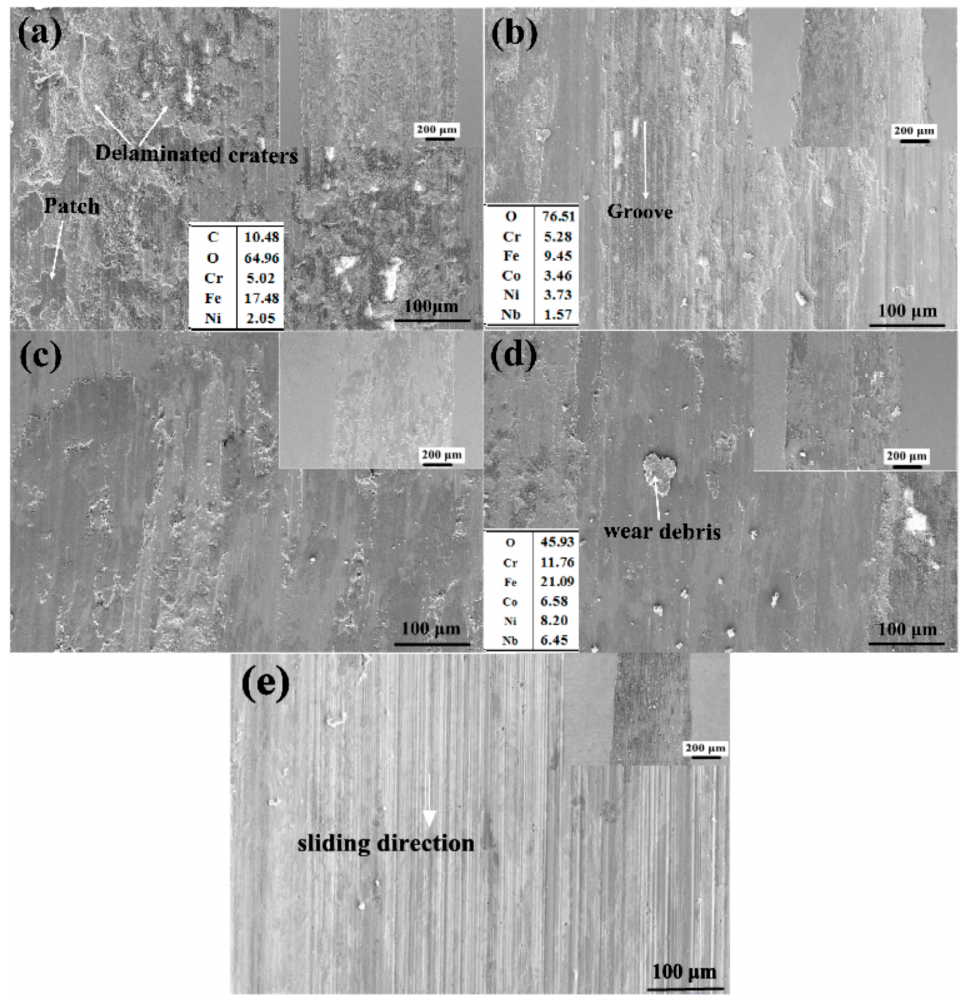
Figure 6. The SEM micrographs of worn surface of samples: ( a ) Substrate, ( b ) Nb0.45, ( c ) Nb0.5, ( d ) Nb0.75, and ( e ) Nb1.0. The insert is the EDS analysis result.